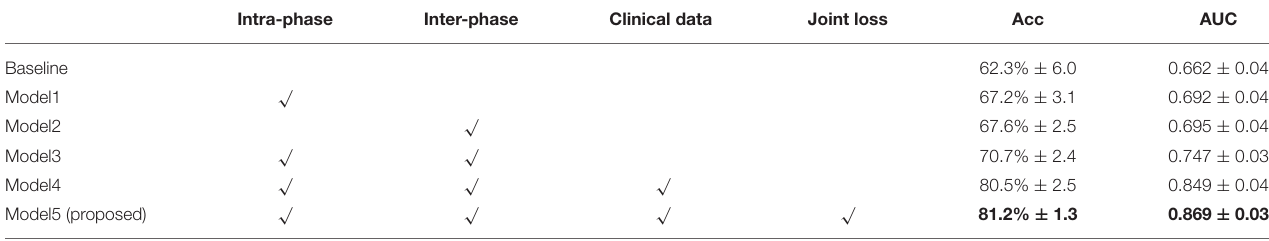
TABLE 6 | Prediction results by ablation study.